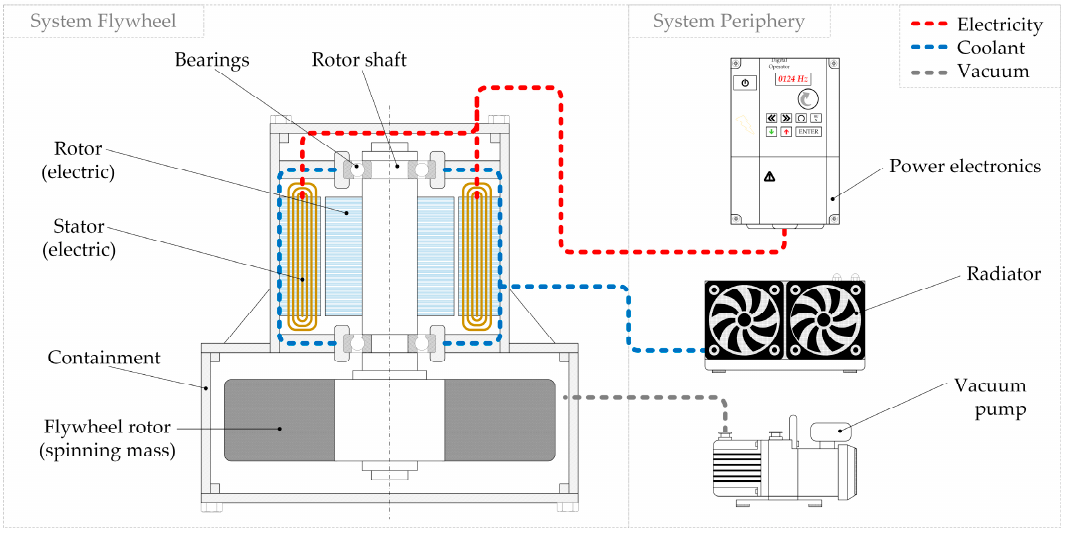
Figure 1 . Typical layout of a non-integrated electromechanical flywheel energy storage system (FESS) [5].